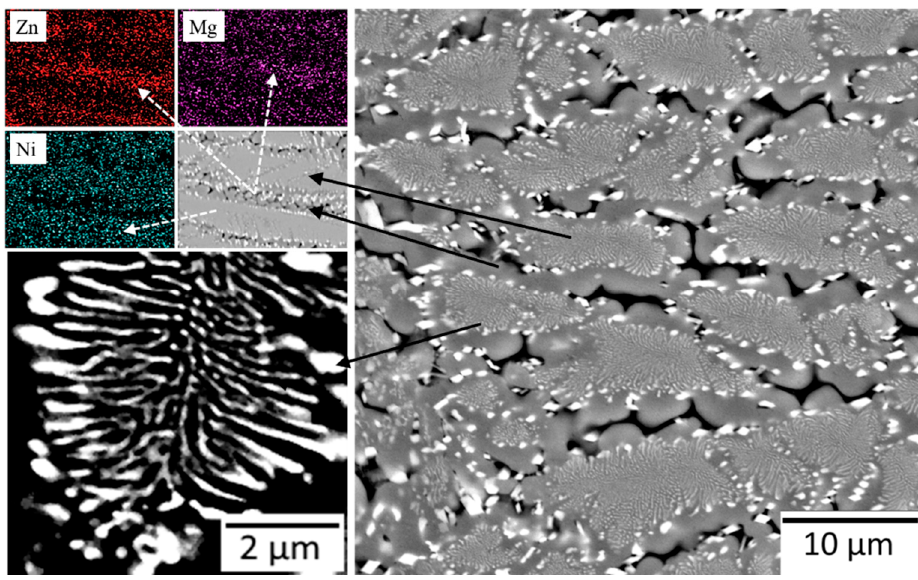
Figure 6. Microstructure of the Al8Zn7Ni3Mg alloy after solidification at 1.4 × 10 3 K/s.